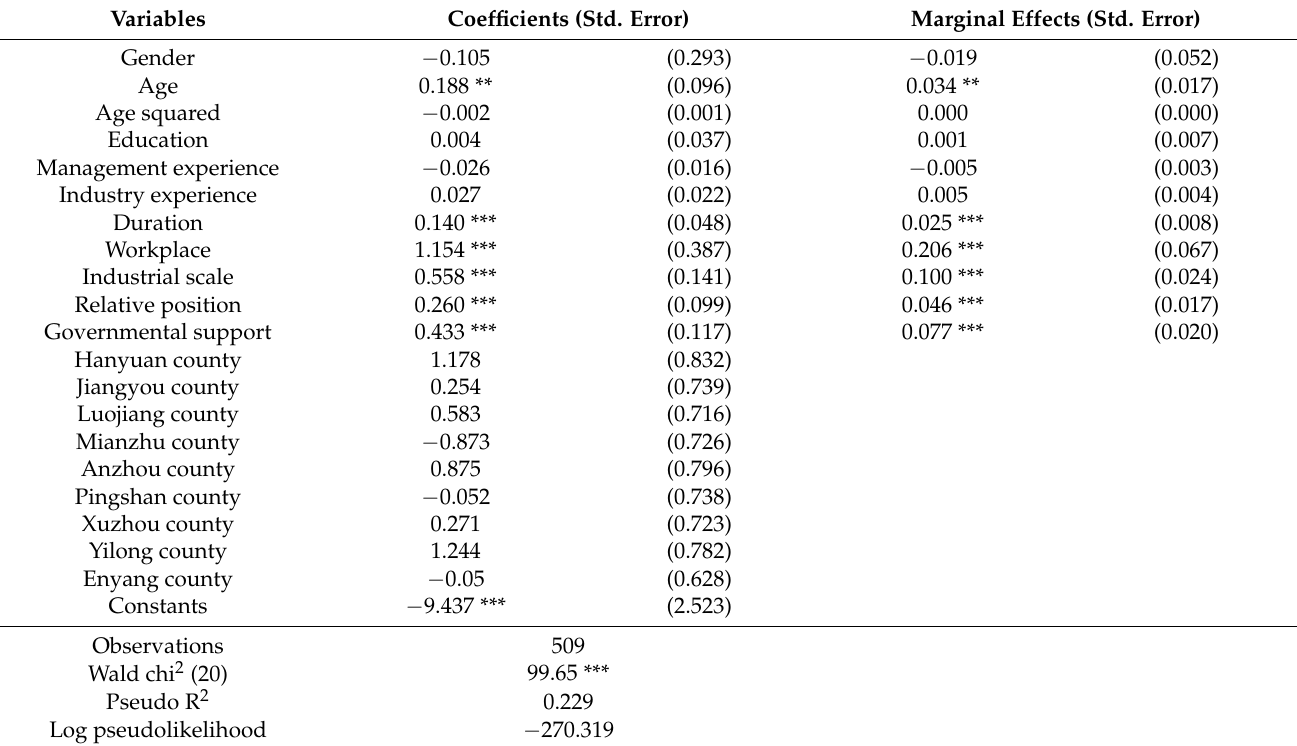
Table 5. Results of selection model for whether cooperatives become demonstration